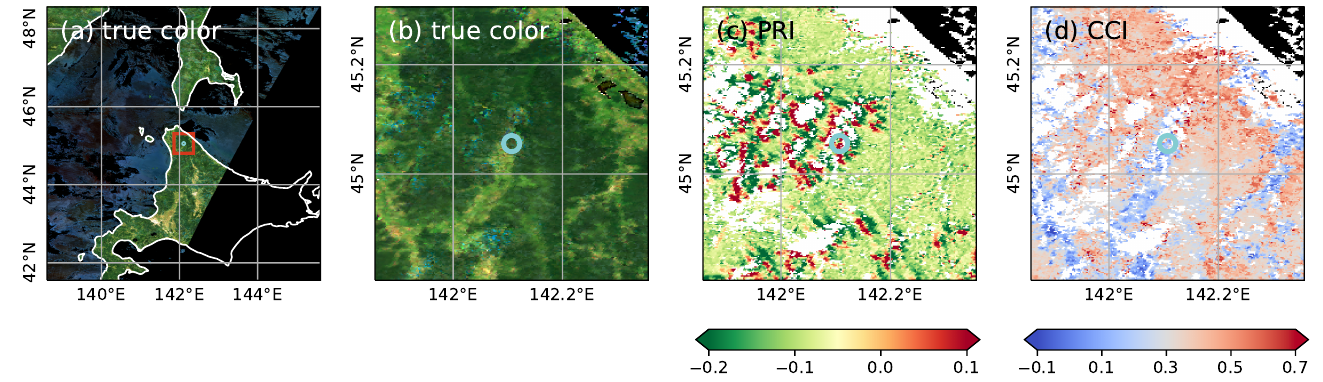
Figure 16. The spatial distribution of PRI satellite and CCI satellite on 8 August 2018 (DOY = 220) around TSE. The cyan circles in each figure indicate the location of TSE. The red rectangle in ( a ) represents the range of ( b – d ). ( a ) shows the true color image of GCOM-C/SGLI. ( b ) shows the true color image, ( c ) shows PRI satellite , and ( d ) shows CCI satellite . ( a , b ) are not screened with the QA flag and ( c , d ) are screened with the QA flag.